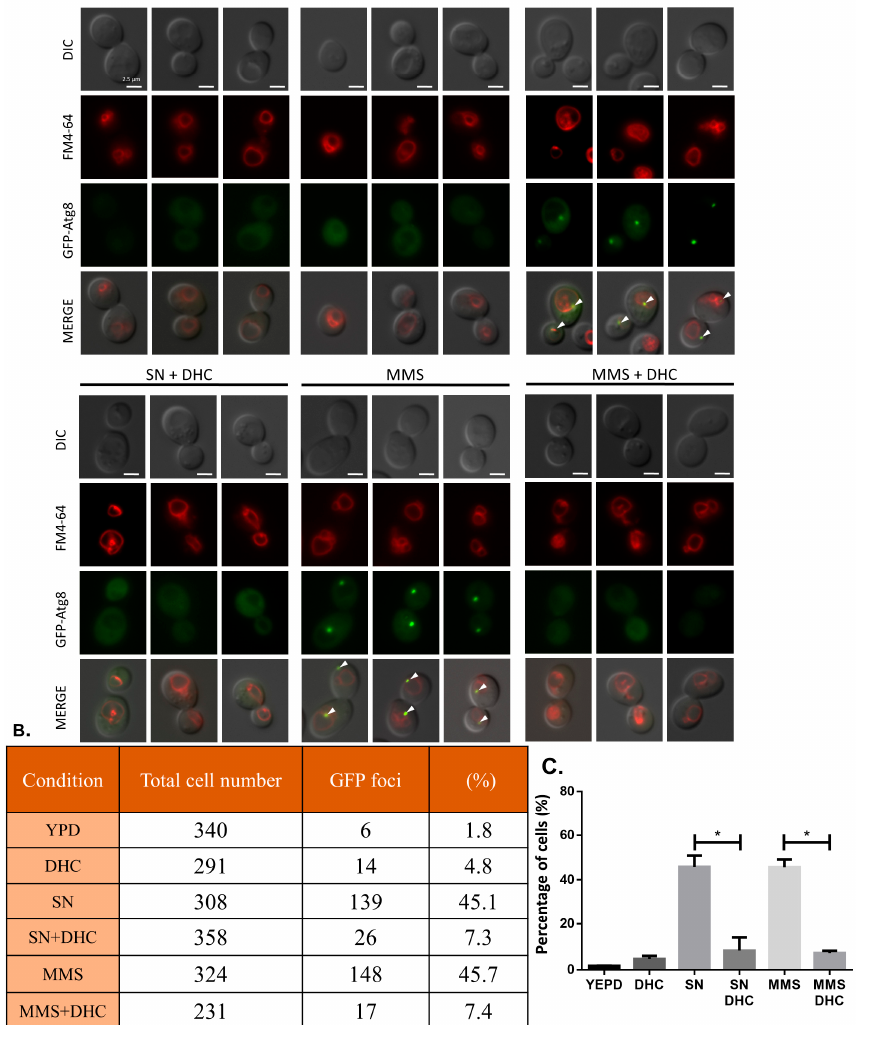
independent experiments. Asterisks (*) indicate significant differences between DHC-treated and untreated cells (* p < 0.05).